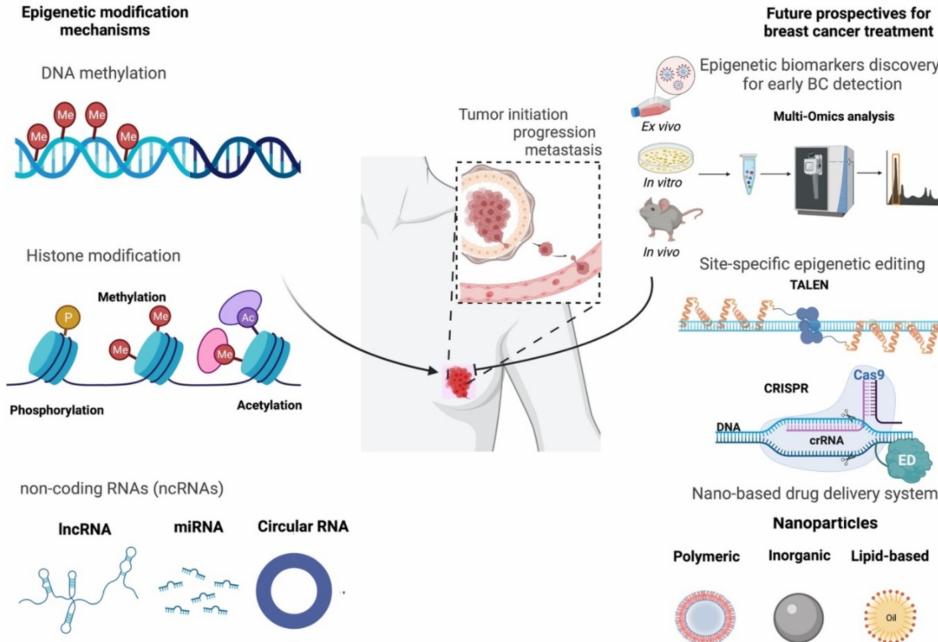
Figure 3. Epigenetic modifications detection and novel strategies for epigenetic editing in the thera- peutic approaches for breast cancer. The aberrant changes of the epigenetic mechanisms, such as DNA methylation, histone modifications, and ncRNAs led to the activation of oncogenes and/or silencing of tumor suppressor genes affecting signaling pathways pivotal for cell maintenance, repair, and homeostasis. These epigenetic modifications regulate and contribute to every single cancer hallmark discussed (Figure 2), and eventually trigger breast cancer initiation, progression, and metastasis. The specific type of epigenetic modifications can be detected using solid and liquid biopsy sampling and the application of integrative analysis of multi-omics (genomics, proteomics, transcriptomics, epige- nomics, metabolomics) approaches. The multi-omics data derived from human and mouse models of BC can help for the identification of aberrant epigenetic profiles, providing insights into cancer biology and rendering novel tumor epigenetic diagnostic, prognostic biomarkers, and epigenetic therapeutic tools with an important clinical value. Strategies for epigenetic corrections in BC patients are depicted. In site-specific epigenetic editing, CRISPR-Cas9 fused to the effector domain (ED) for epigenetic corrections, and TALEN strategies integrated with cell-specific promoters can be used to restore normal chromatin structure and correct specific epigenetic aberration localized to